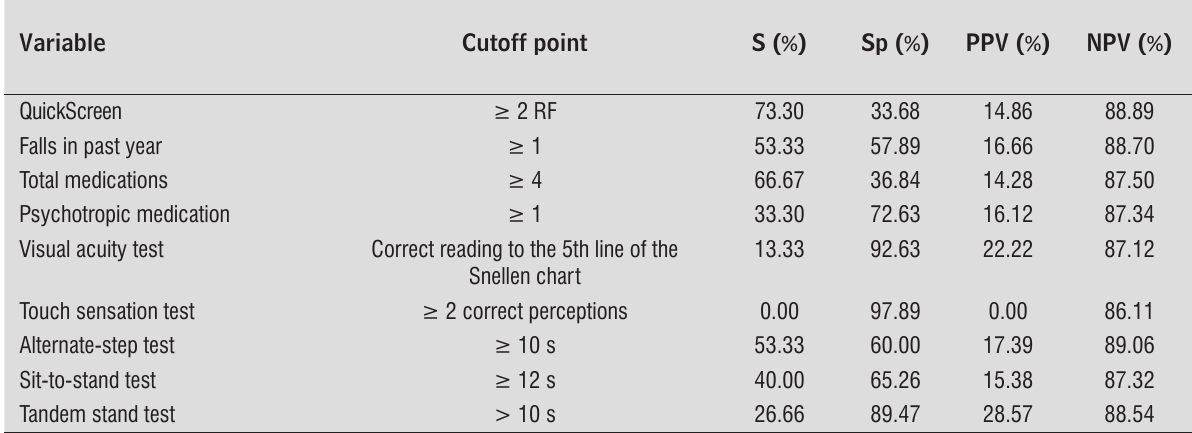
Table 4 - Sensitivity, Specificity, Positive Predictive Value, and Negative Predictive Value of the Quickscreen Clinical Fall Risk Assessment test and each risk factor in older women with low bone density (n =